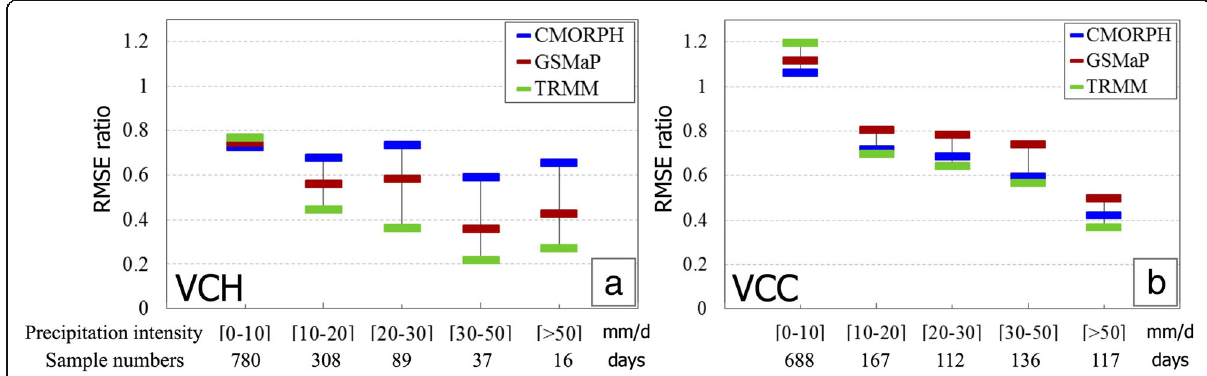
Fig. 10 RMSE ratio of the SPDs for the different categories of regional mean precipitation intensity in the VnGP a during MJJA over the VCH and b during SOND over the VCC. The numbers of days (i.e., sample numbers) for each category of VnGP precipitation intensity during 2001 – 2010 are also